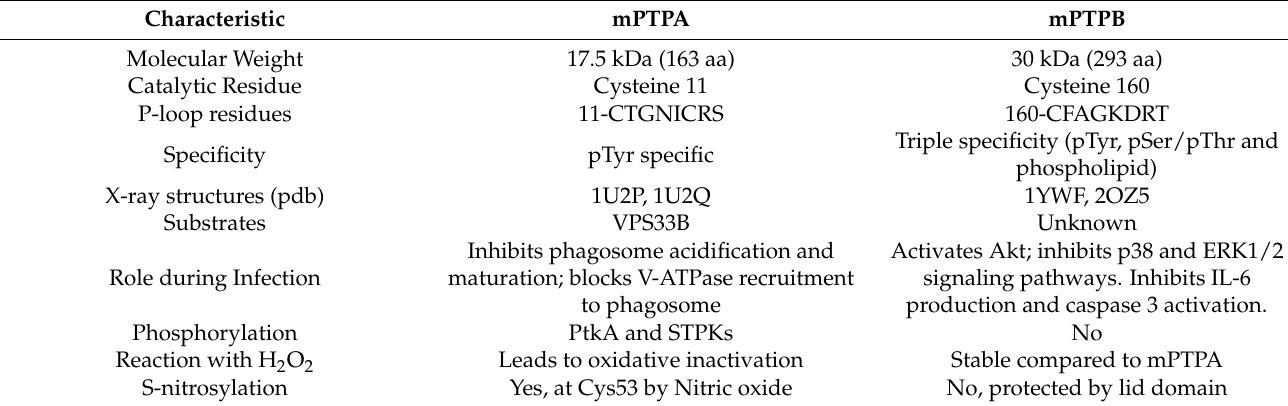
Table 1. Comparison table for mPTPA and mPTPB.